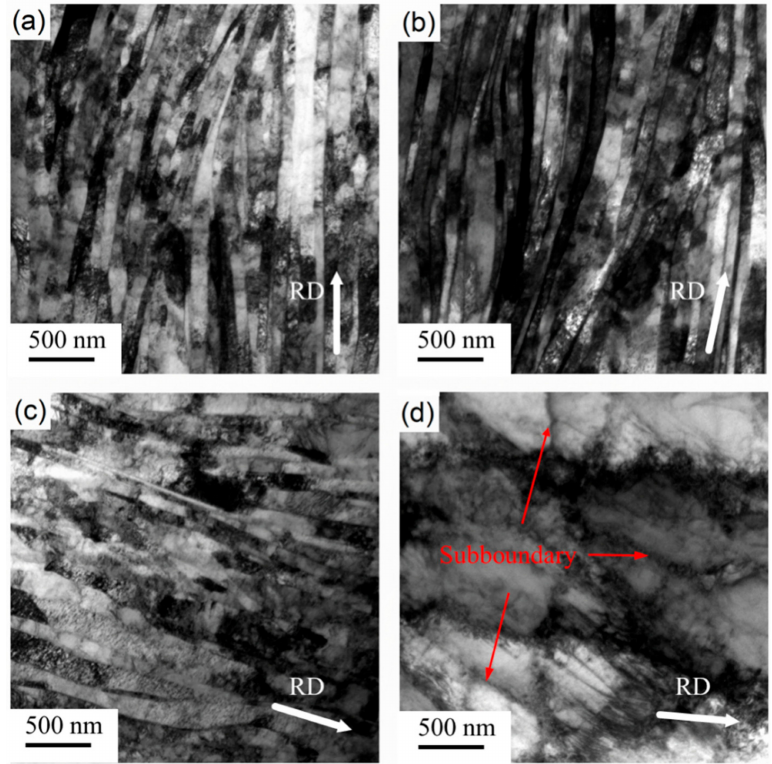
Figure 2. TEM images of Ni sheets subjected to ( a ) cryorolling and subsequent annealing at ( b ) 75 ◦ C, ( c ) 160 ◦ C, and ( d ) 245 ◦ C for 1